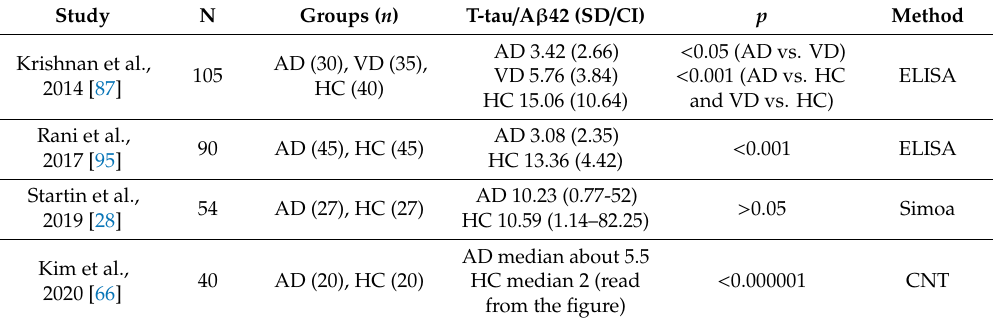
Table 4. T-tau / A β 42 diagnostic usability studies.